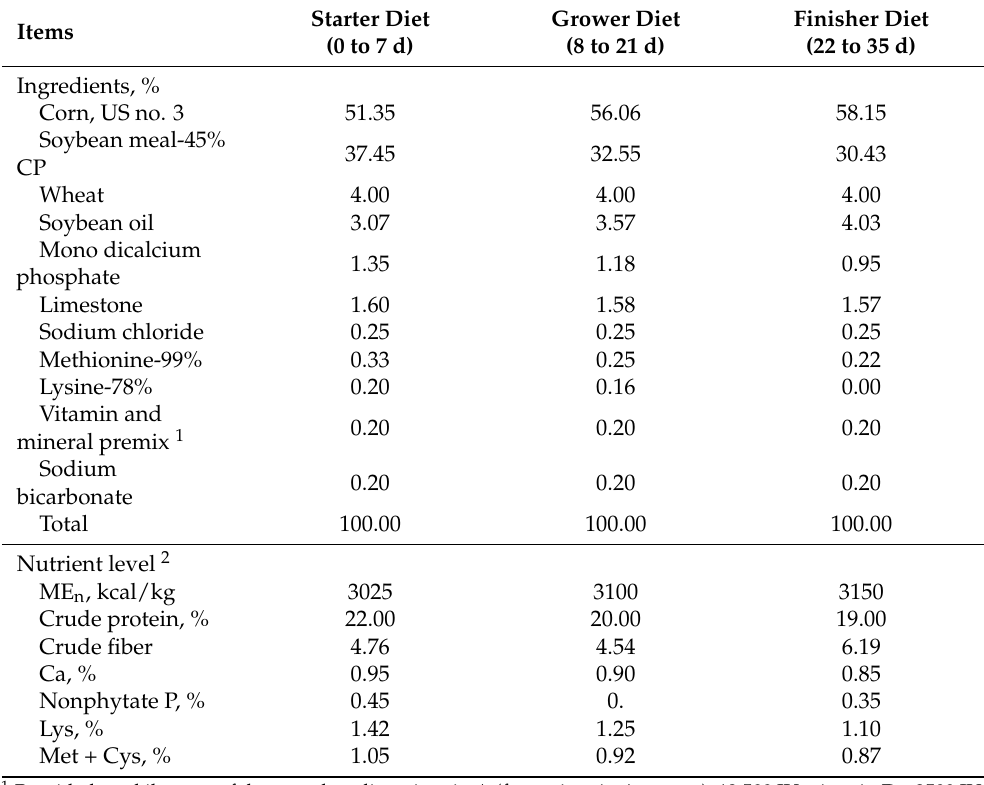
Table 1. Ingredients and nutrient level of experimental diets (as-fed